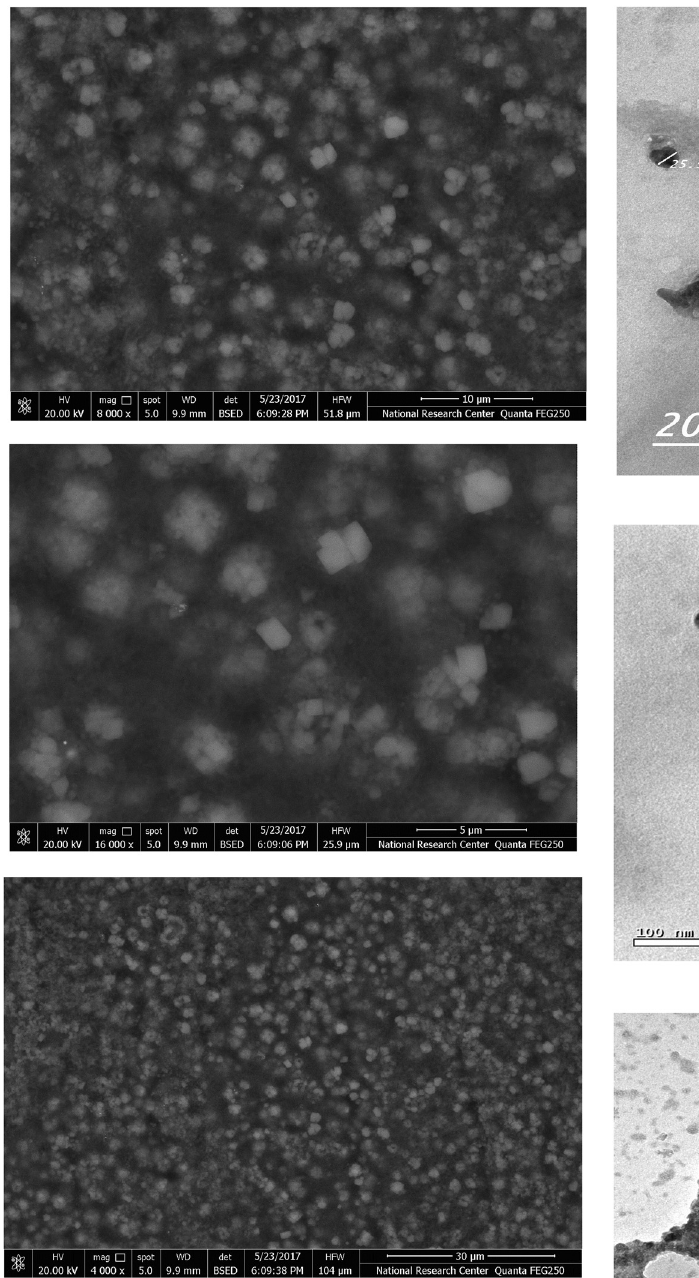
Figure 4: SEM of Ag - NPs.